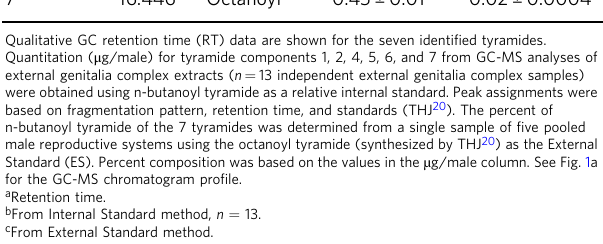
Table 1 Tyramide identi fi cation and quantity.